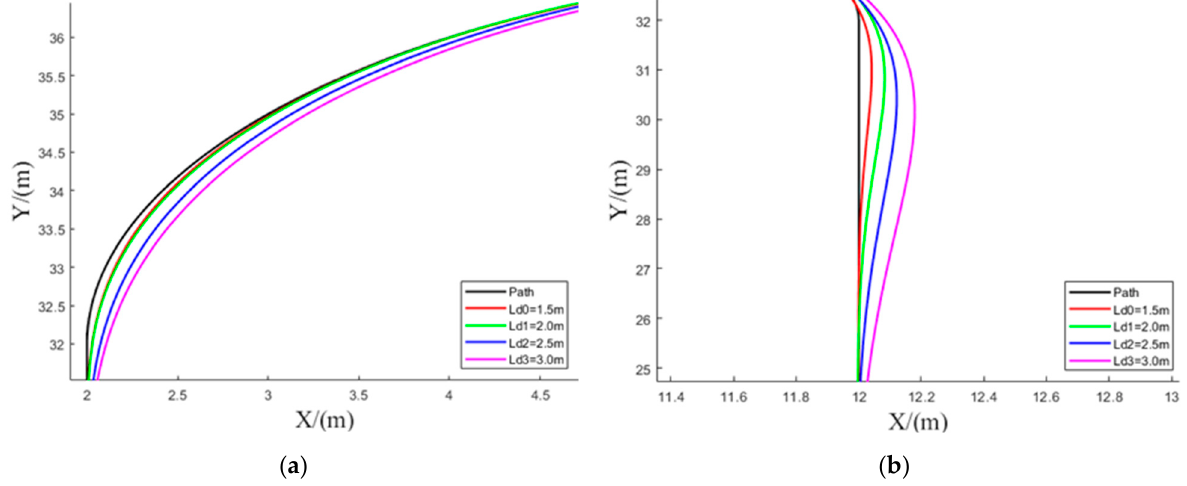
Figure 7. Local enlargement diagram. ( a ) Partial enlargement at A; ( b ) Partial enlargement at B. The forward-looking distance of a pure tracking algorithm is generally represented by (14).